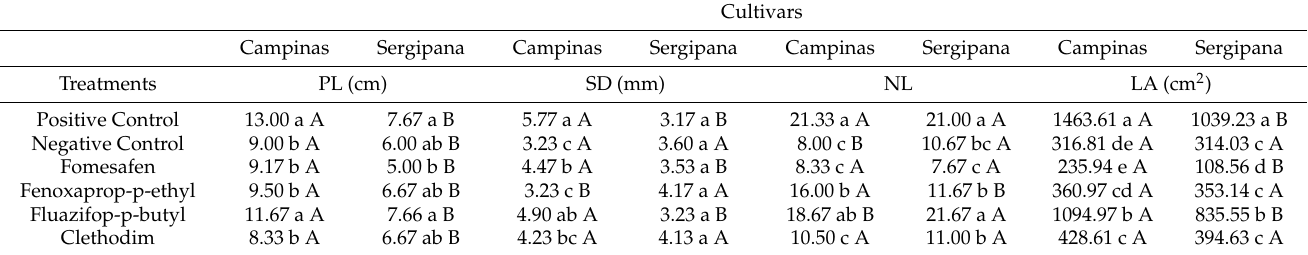
Table 2. Plant height (PL), stem diameter (SD), number of leaves (NL), and leaf area (LA) of cassava in the cultivars Campinas and Sergipana after the application of herbicides in weed management 33 days after the